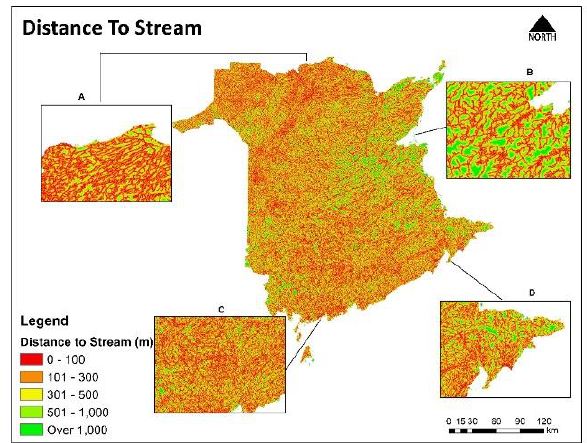
Figure A3. Distance to Stream.